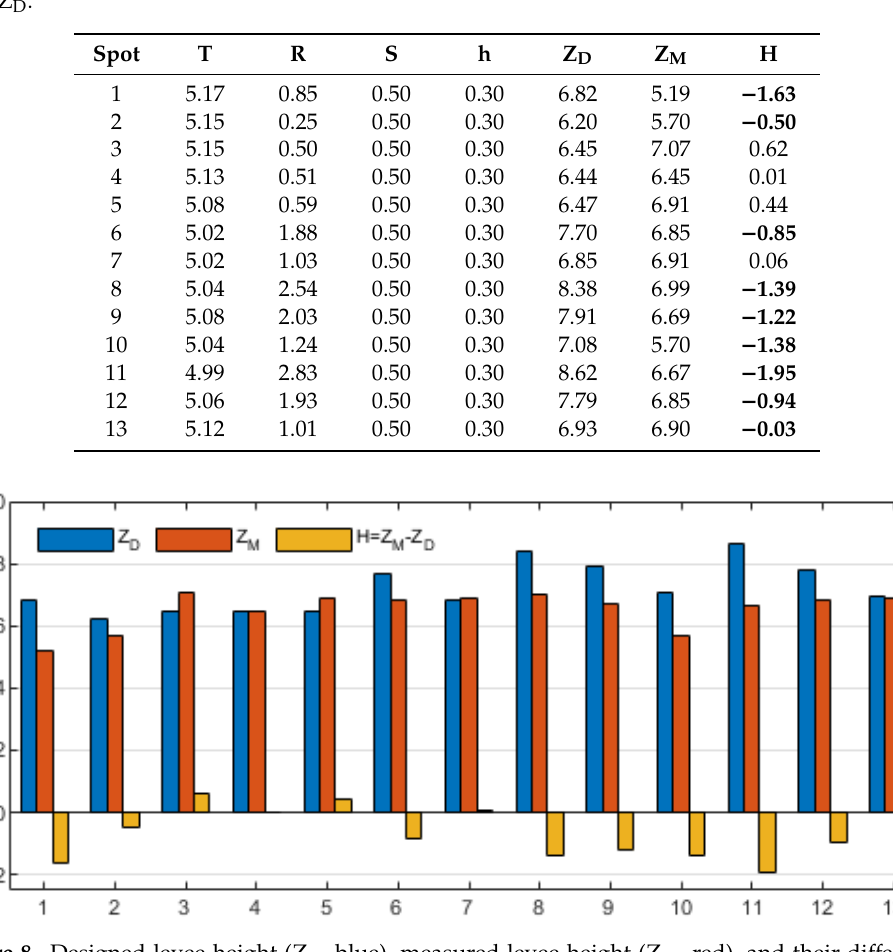
Figure 8. Designed levee height (Z D , blue), measured levee height (Z M , red), and their difference (H, orange).